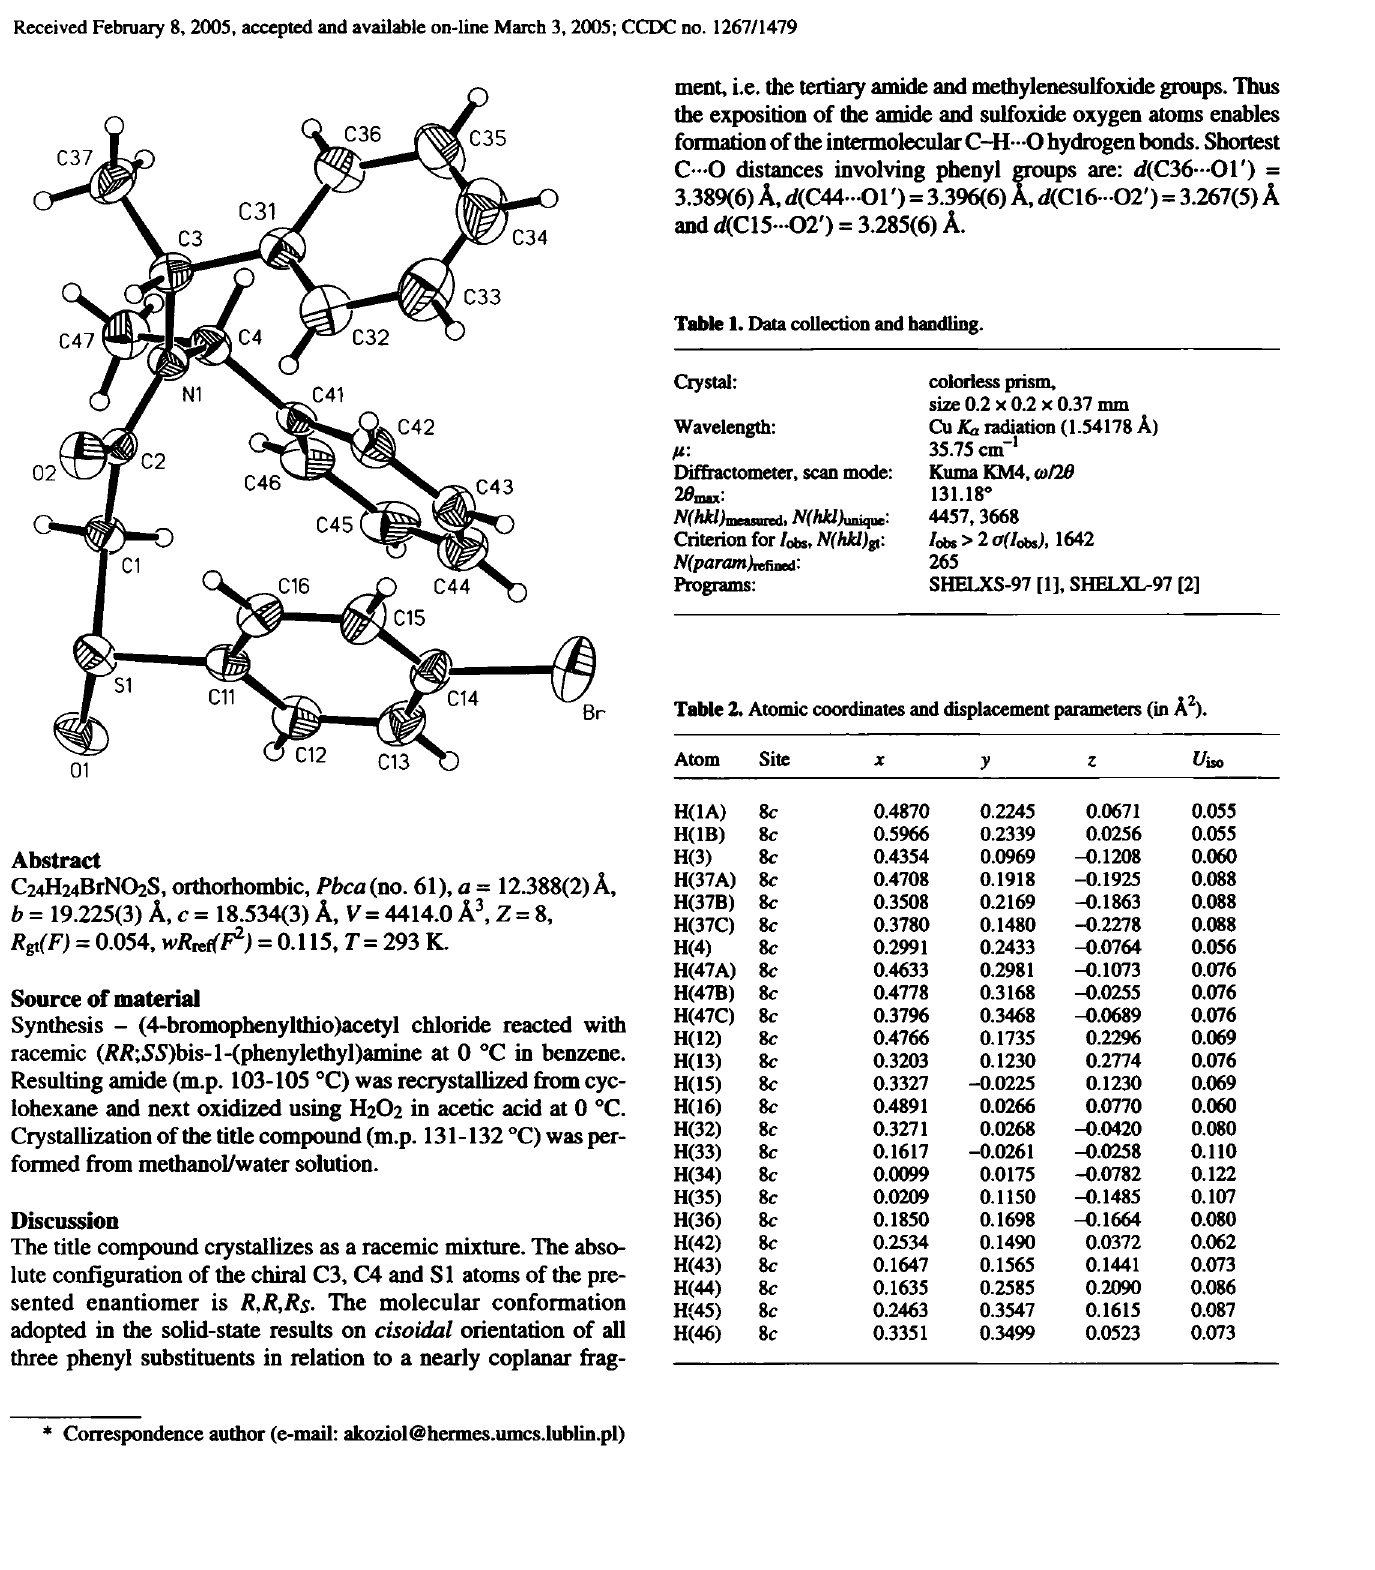
Table 1. Data collection and handling.